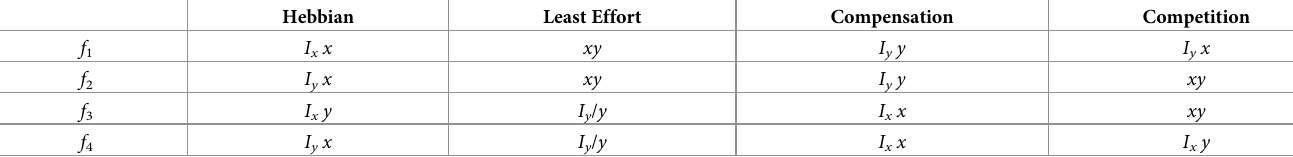
Table 2. The pairwise, multiplicative terms corresponding to each of the four learning